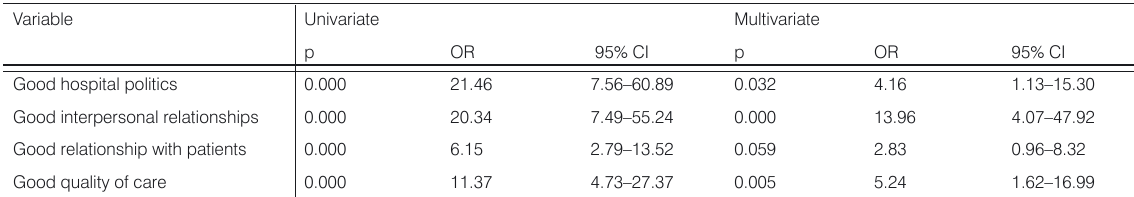
Table 2. Predictors for job satisfaction among HCWs.